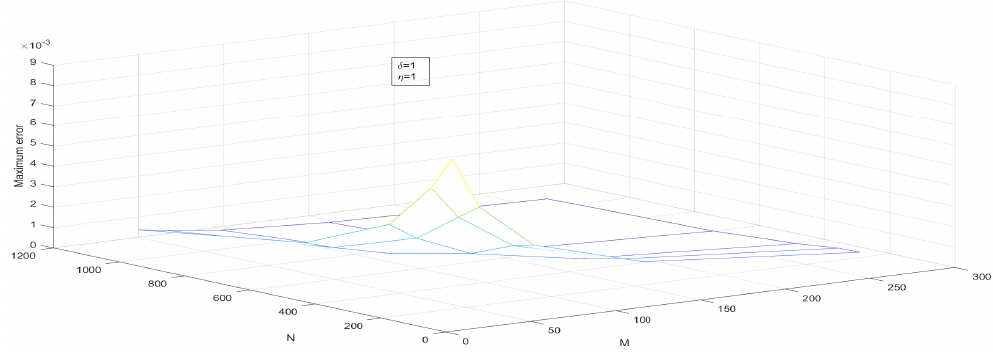
Figure 7. U 1 —the maximum point-wise error of Example 1 for Case 1.